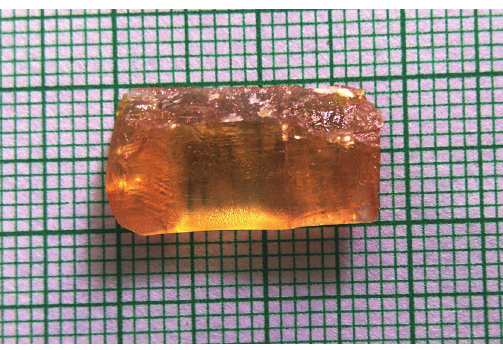
Figure 1: Photograph of as grown 4BPTS single crystal.